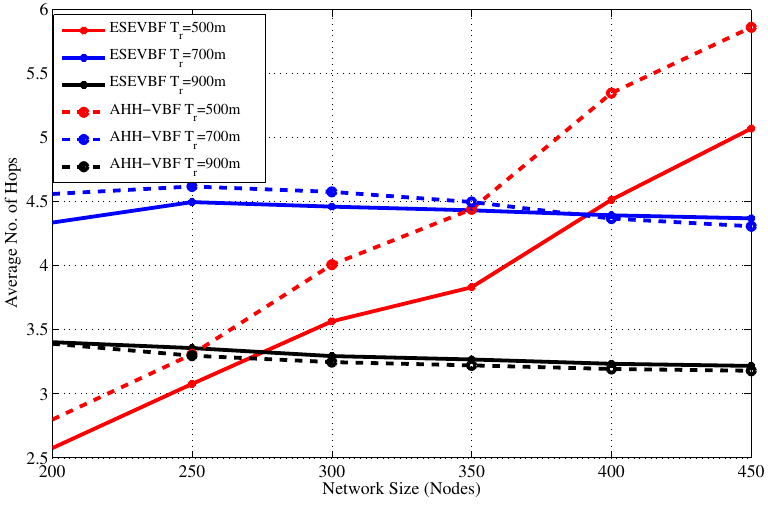
Figure 15. Average No. of Hops data messages traversed versus the network size.